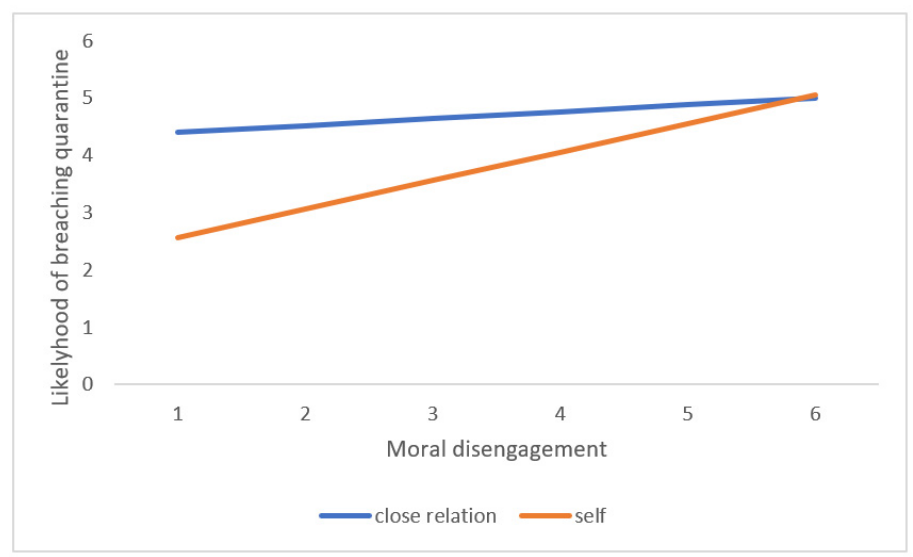
Figure 2. Interaction between protagonist IV and moral disengagement.